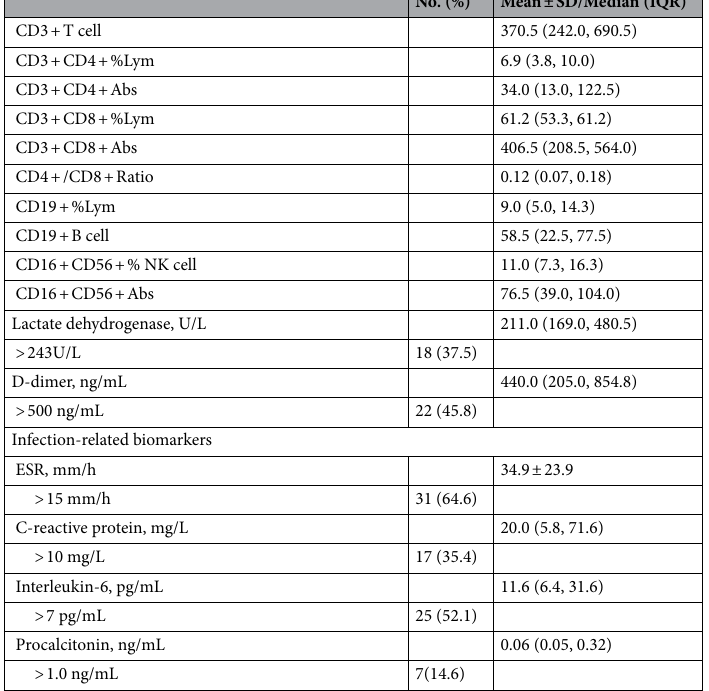
Table 1. Characteristics of 48 inpatients who had done mNGS testing.